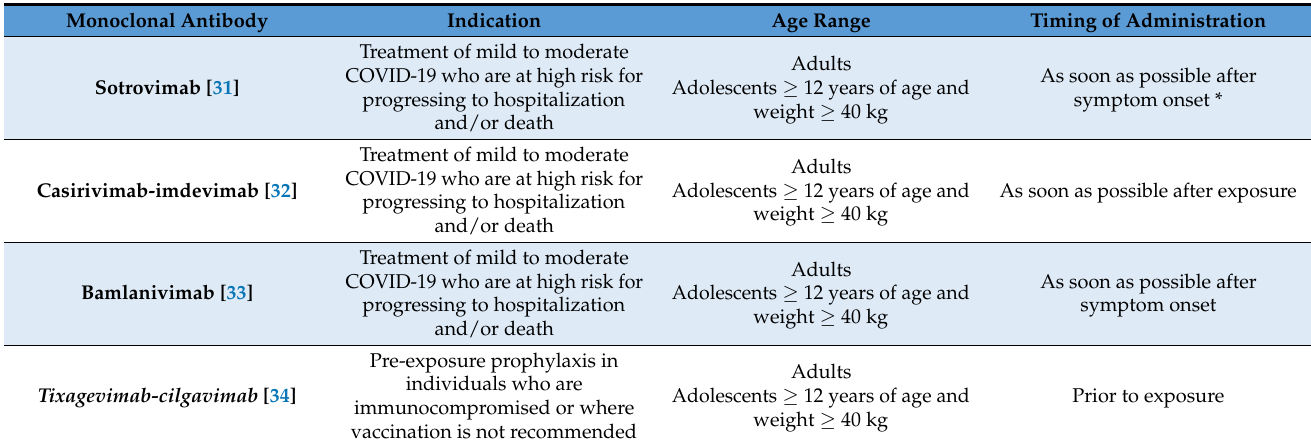
Table 1. Health-Canada-approved monoclonal antibodies for the treatment and prevention of COVID-19.